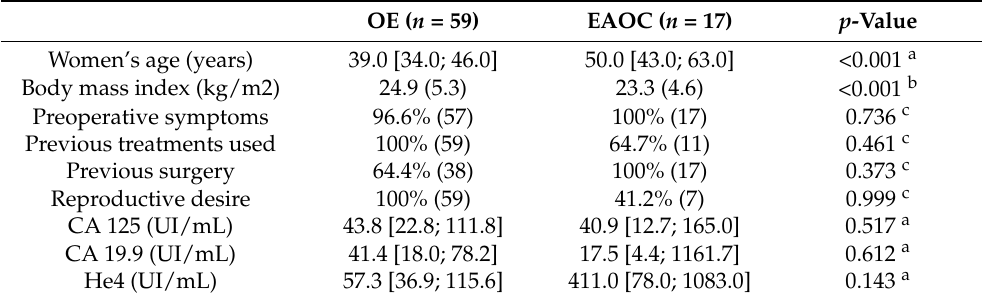
Table 1. Baseline clinical characteristics between